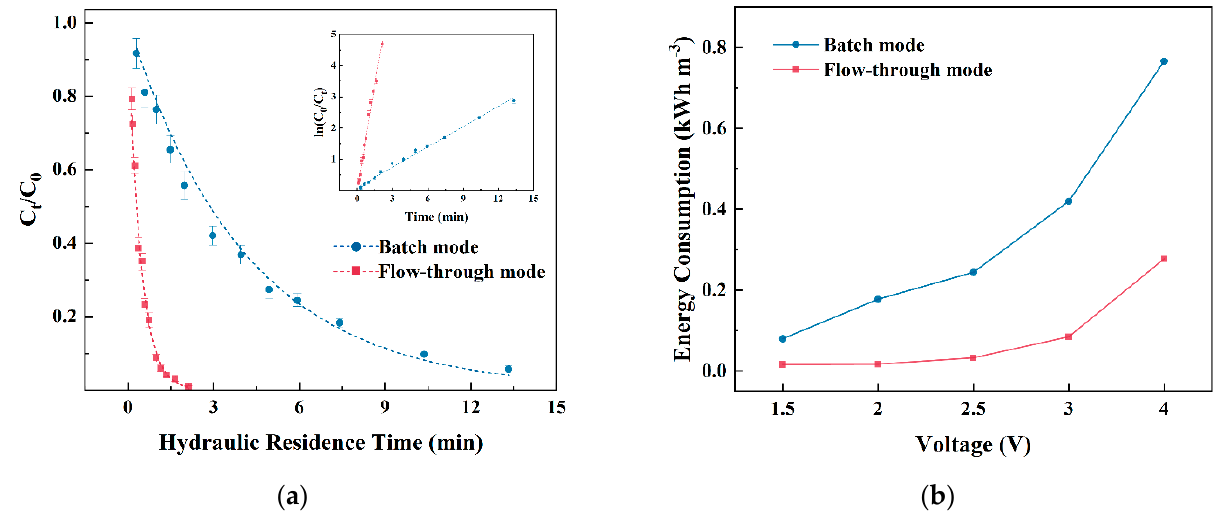
Figure 8. ( a ) Kinetics and ( b ) energy consumption of TC degradation under batch and flow-through modes.